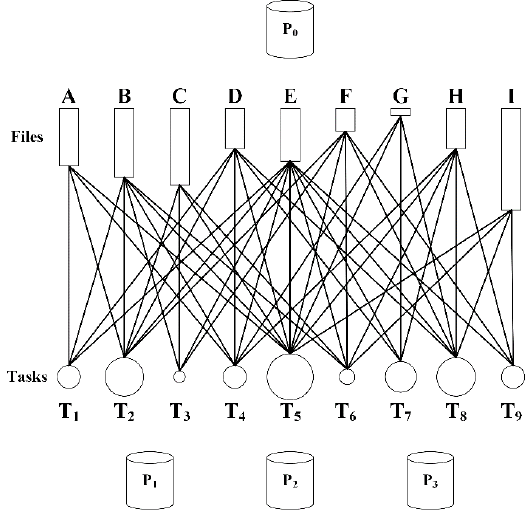
Figure 6. Hypergraph-based task-scheduling model.